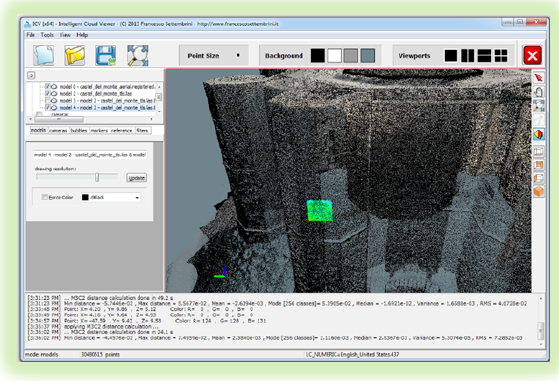
Figure 27. Comparison area selection with M3C2 The results are displayed in both the terms of the map and the histogram (fig. 28).